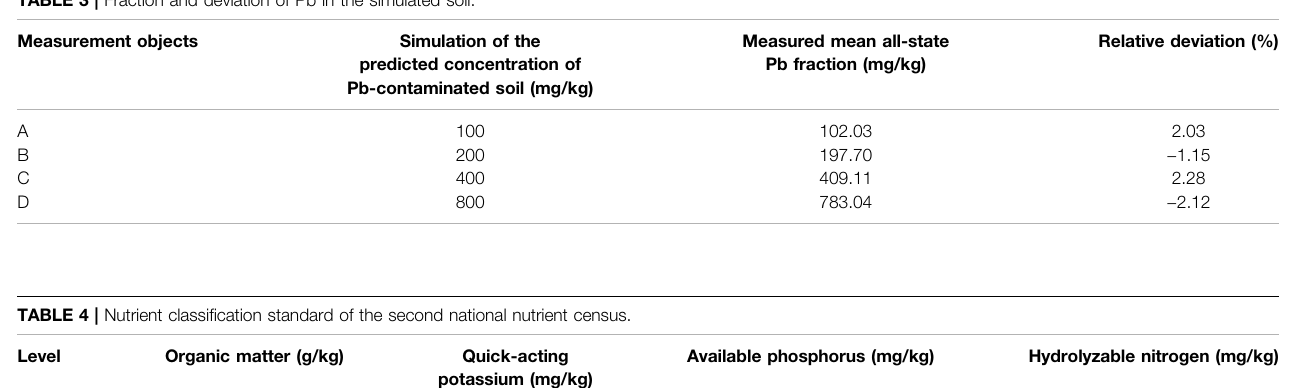
TABLE 3 | Fraction and deviation of Pb in the simulated soil.